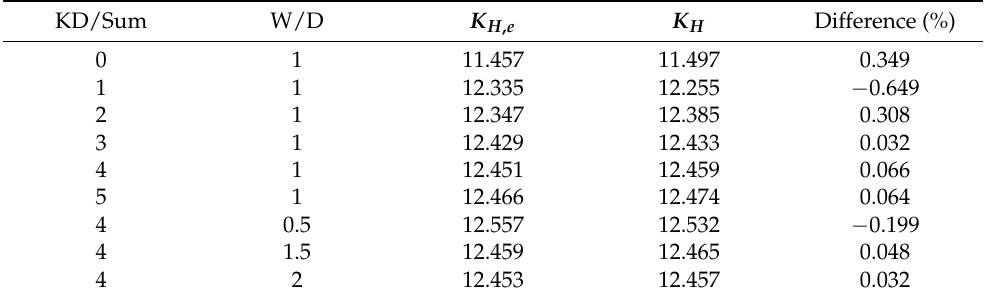
Table 9. Comparison between the horizontal stiffness coefficients of a spudcan embedded in pure elastic and elastic perfectly plastic soil.